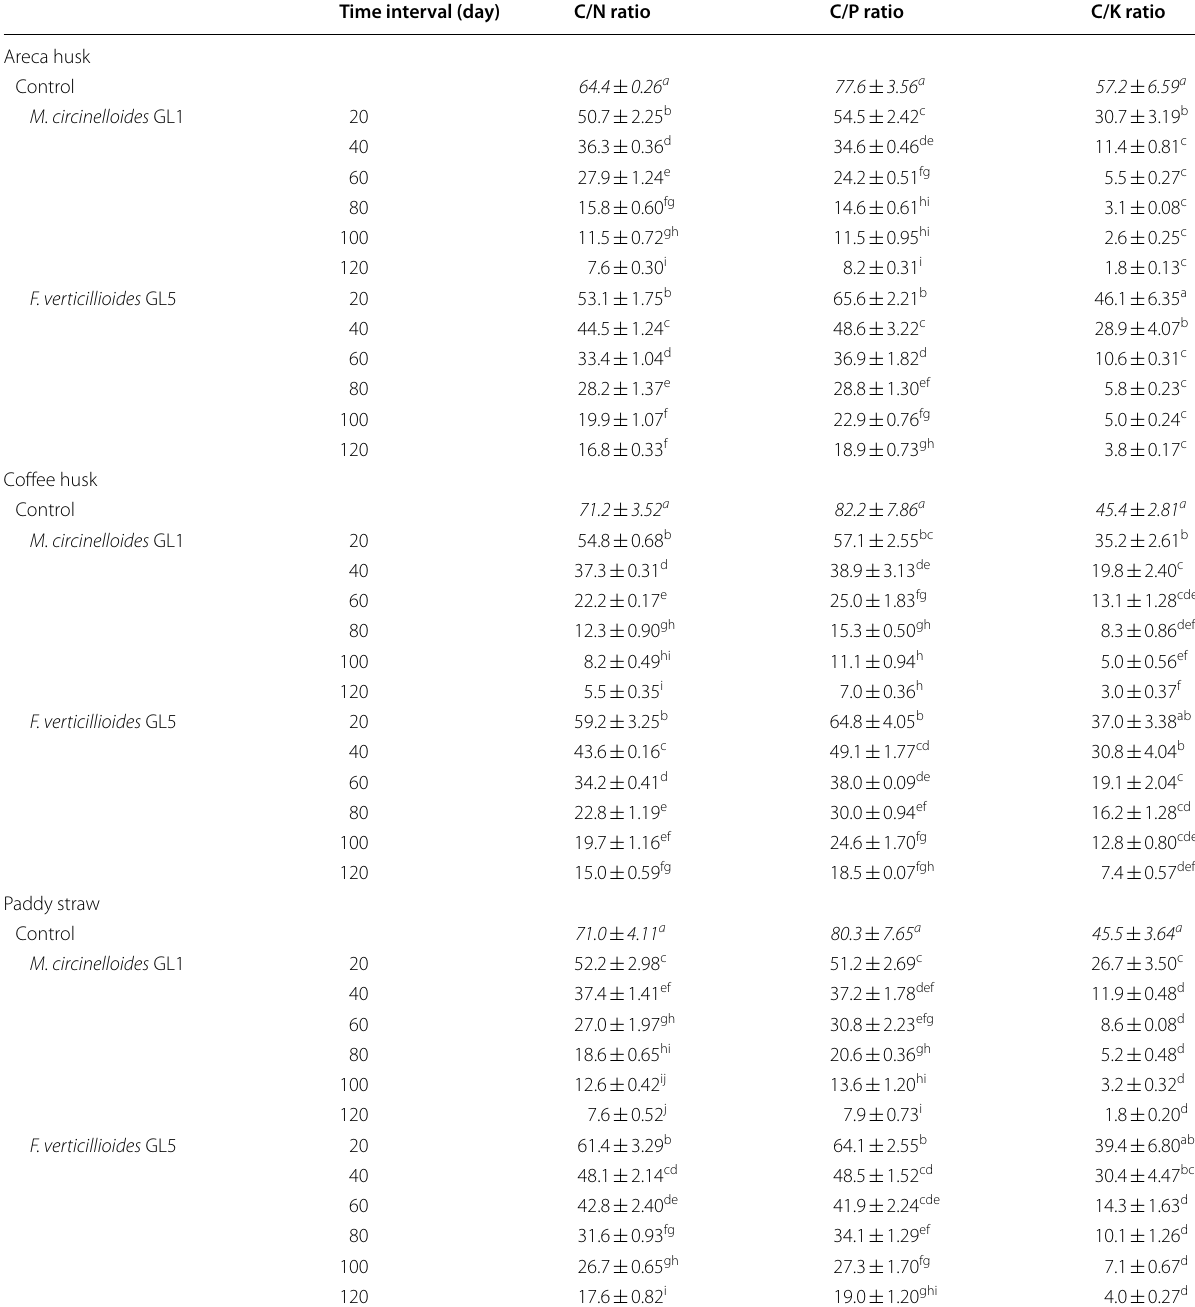
Table 2 Changes in carbon to nutrient supply ratios in solid substrates treated with ligninolytic fungi during solid-state fermentation in different time